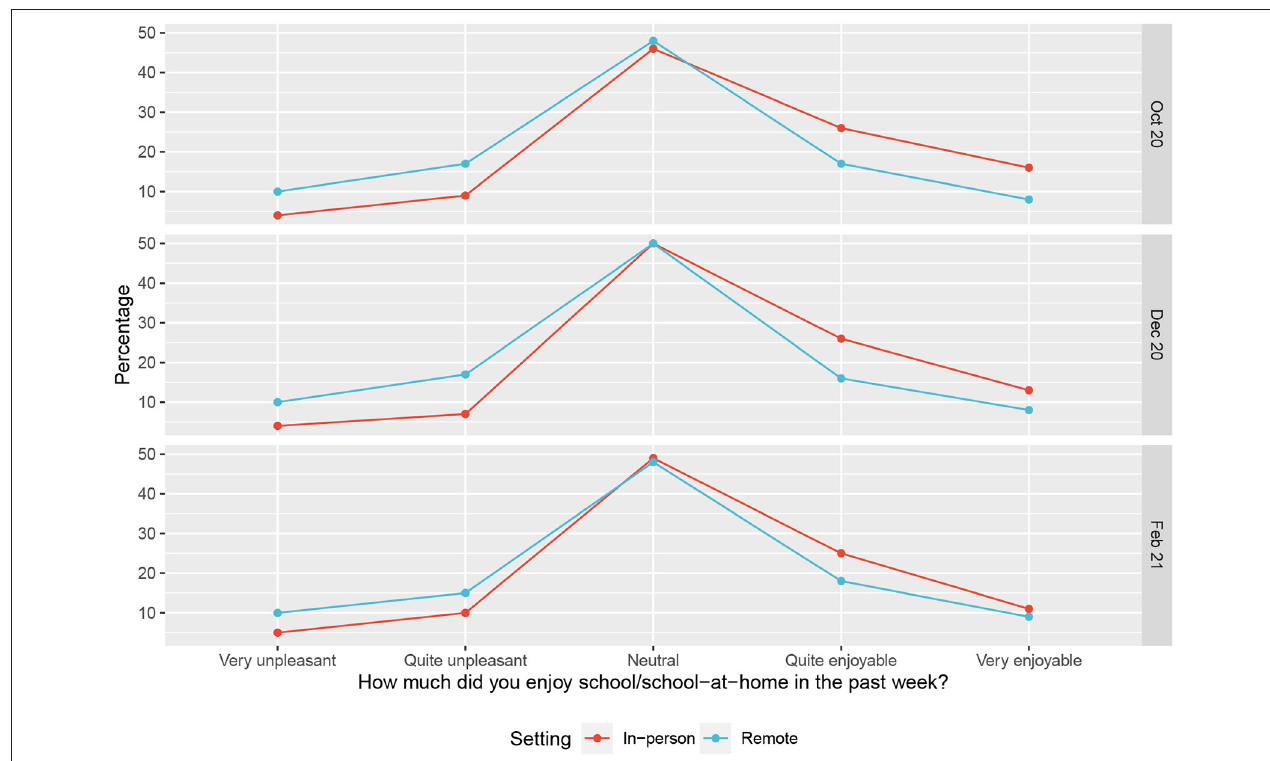
FIGURE 1 | Response distribution (in percent) regarding youth school enjoyment, as a function of school setting (in-person or remote) and time points (Oct 20, Dec 20, or Feb 21).